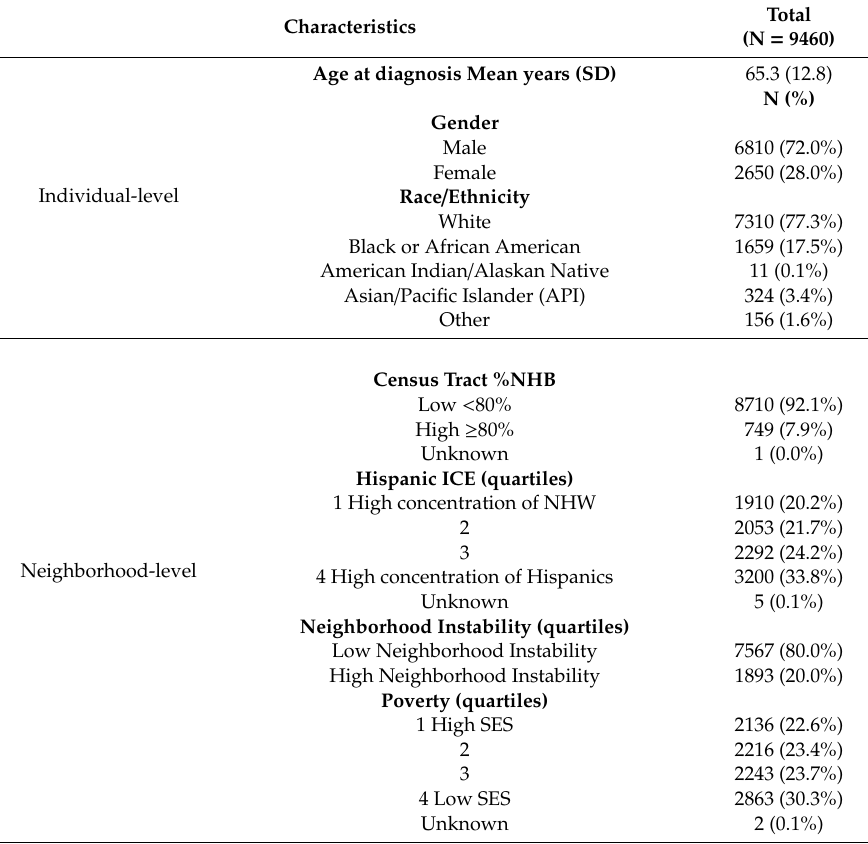
Table 1. Pennsylvania Liver Cancer Patient Characteristics (N =